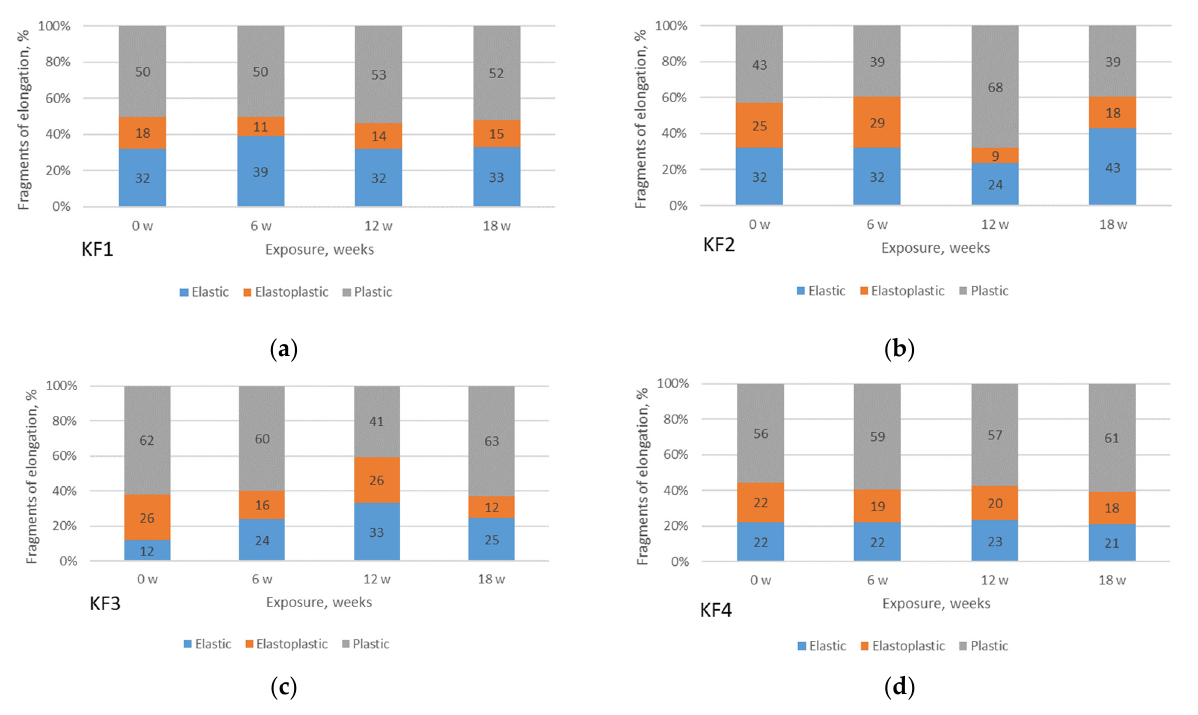
Figure 11. Fragments of elongation of materials exposed to aging indoor: ( a ) material KF1; ( b ) material KF2; ( c ) material KF3; ( d ) material KF4.